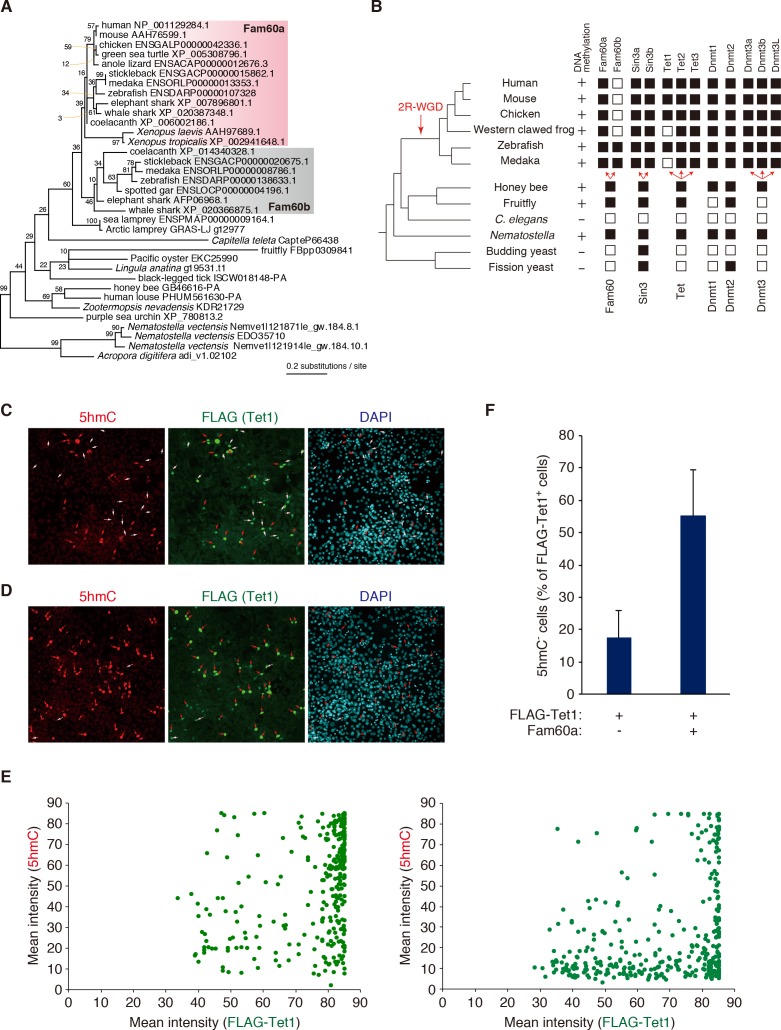
Phylogenetic and functional relation between Fam60a and Tet1.(A) Molecular phylogeny of Fam60a and related proteins. The tree was inferred with the maximum-likelihood method and 99 amino acid residues. Bootstrap values are indicated at individual nodes. (B) Gene repertories for Fam60, Sin3, Tet, and Dnmt families. Black boxes indicate the presence of at least one phylogenetically validated ortholog, whereas white boxes indicate the absence of orthologs. 2R-WGD, two rounds of whole-genome duplication. The presence or absence of DNA methylation in individual species based on current knowledge (Suzuki and Bird, 2008; Zemach and Zilberman, 2010) is also shown. (C and D) Fam60a inhibits Tet1 activity in NIH3T3 cells. Immunofluorescence staining of 5hmC and FLAG-Tet1 was performed for NIH3T3 cells expressing FLAG-Tet1 either together with Fam60a (C) or alone (D). The cells were analyzed 24 hr after the induction of FLAG-Tet1 expression by doxycycline administration. Nuclei were stained with 4',6-diamidino-2-phenylindole (DAPI). Red arrows indicate cells positive for both 5hmC and FLAG immunoreactivity. White arrows indicate cells positive for FLAG but negative for 5hmC. (E) Plots of mean fluorescence intensity for 5hmC versus FLAG-Tet1 in cells expressing FLAG-Tet1 without (left) or with (right) Fam60a as in (C) and (D). (F) Proportion of FLAG-Tet1+ cells that were negative for 5hmC in experiments similar to that in (C) and (D). Data are means ± s.d. for three independent experiments. *p<0.05 (Student’s unpaired t test). See also Figure 6—figure supplements 1 and 2.10.7554/eLife.36435.034Figure 6—source data 1.Numerical data of Figure 6E.10.7554/eLife.36435.035Figure 6—source data 2.Numerical data of Figure 6F.